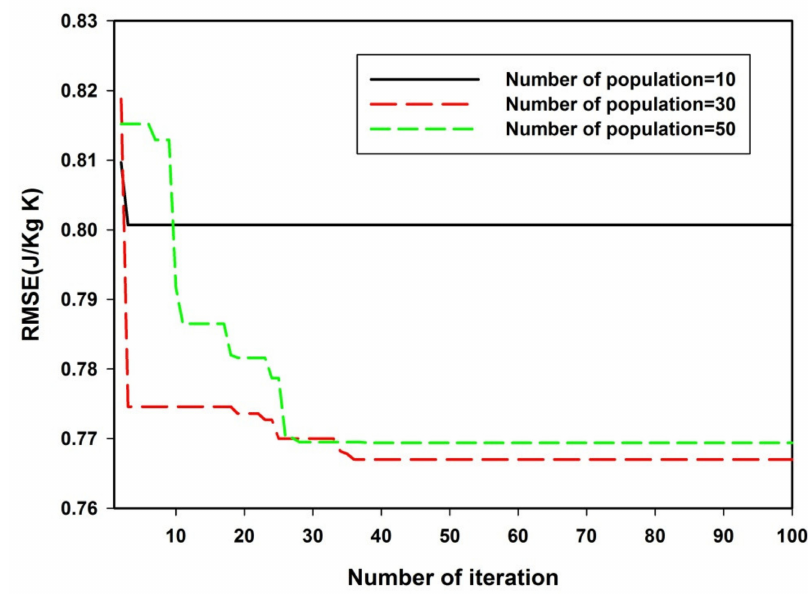
Figure 2. Dependence of convergence of GSA-SVR-crystal model on the density of search space.